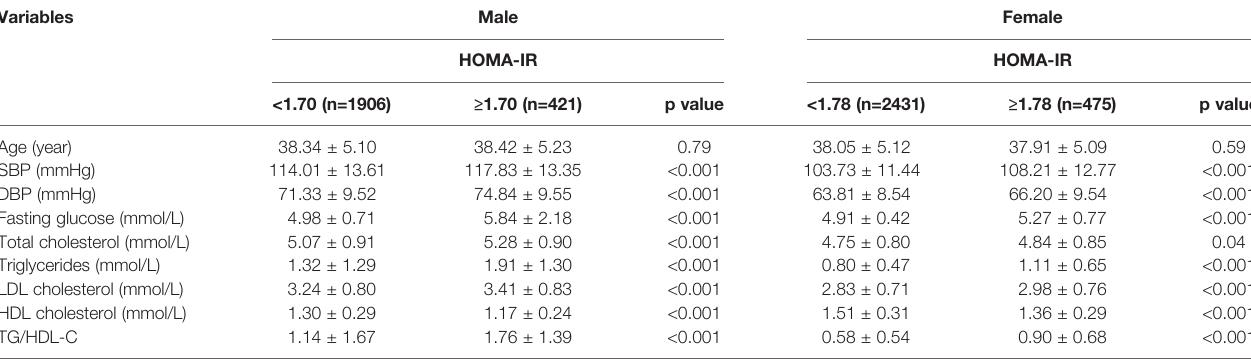
TABLE 3 | Demographic and cardiometabolic risk factors in normal weight (body mass index 18.5 to 23.9 kg/m 2 ) adults by HOMA-IR (N=5233) and gender.